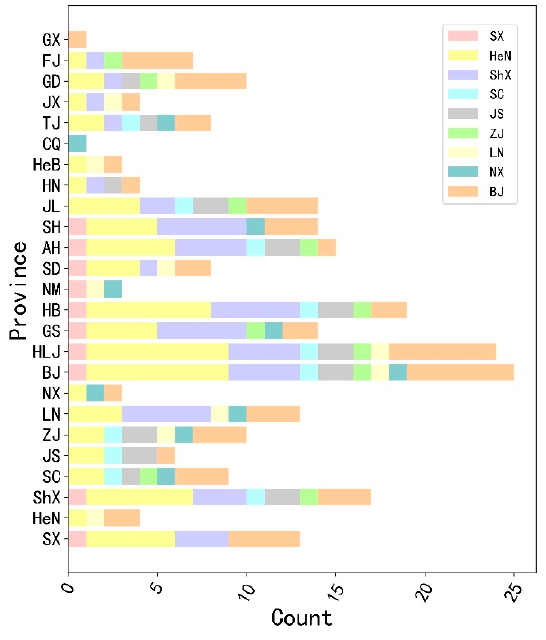
Figure 7. Capital ‐ regional “connectivity” statistical diagram. Figure 7. Capital-regional “connectivity” statistical